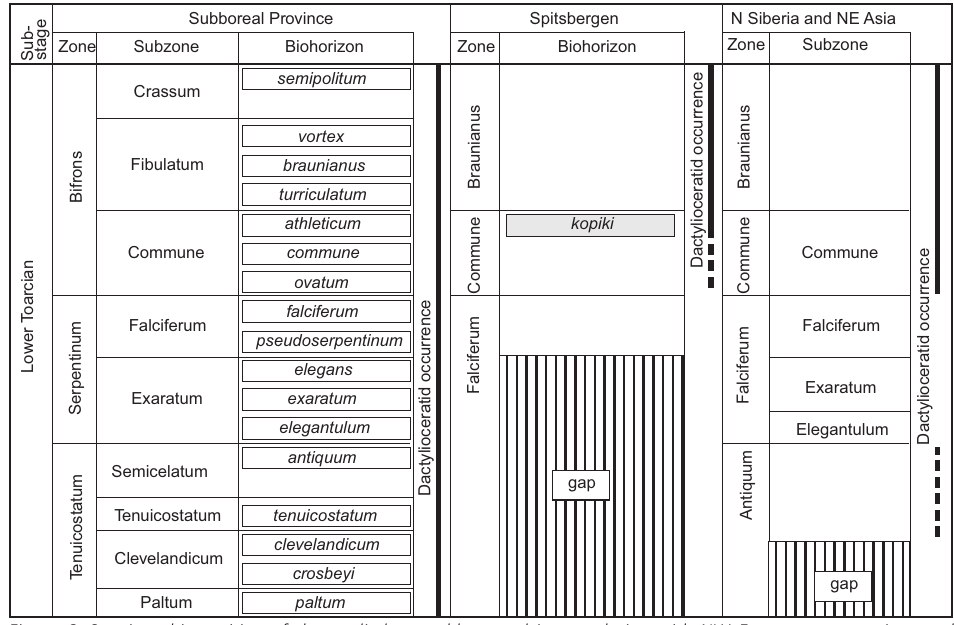
Figure 6. Stratigraphic position of the studied assemblage and its correlation with NW European ammonite zonal scale. Succession of Subboreal Province after Page (2004); succession of Spitsbergen after Shurygin et al. (2011) with corrections; succession of Northern Siberia and Northeast Asia after Shurygin et al.